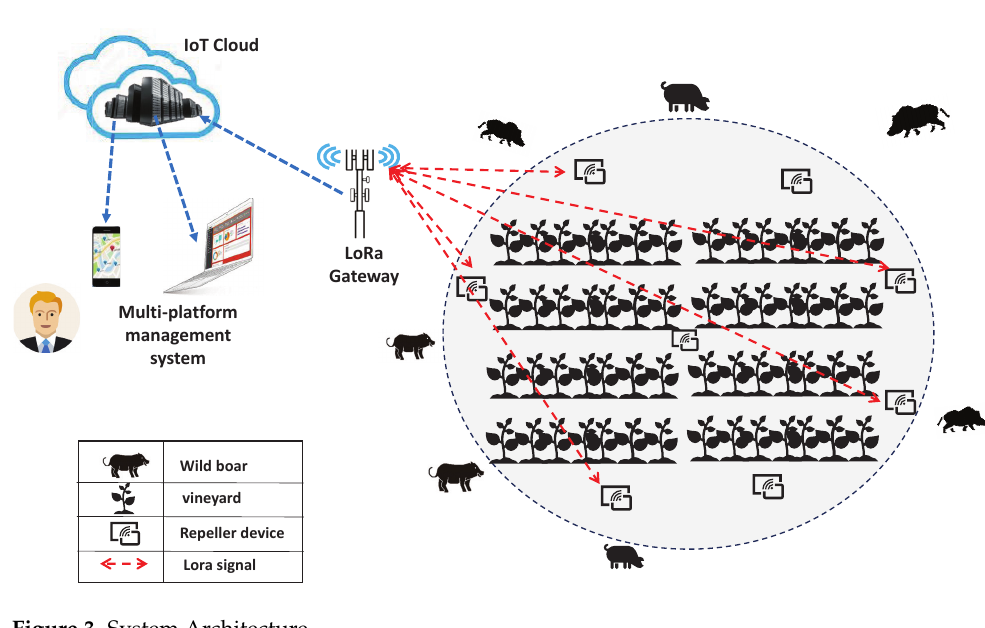
Figure 3. System